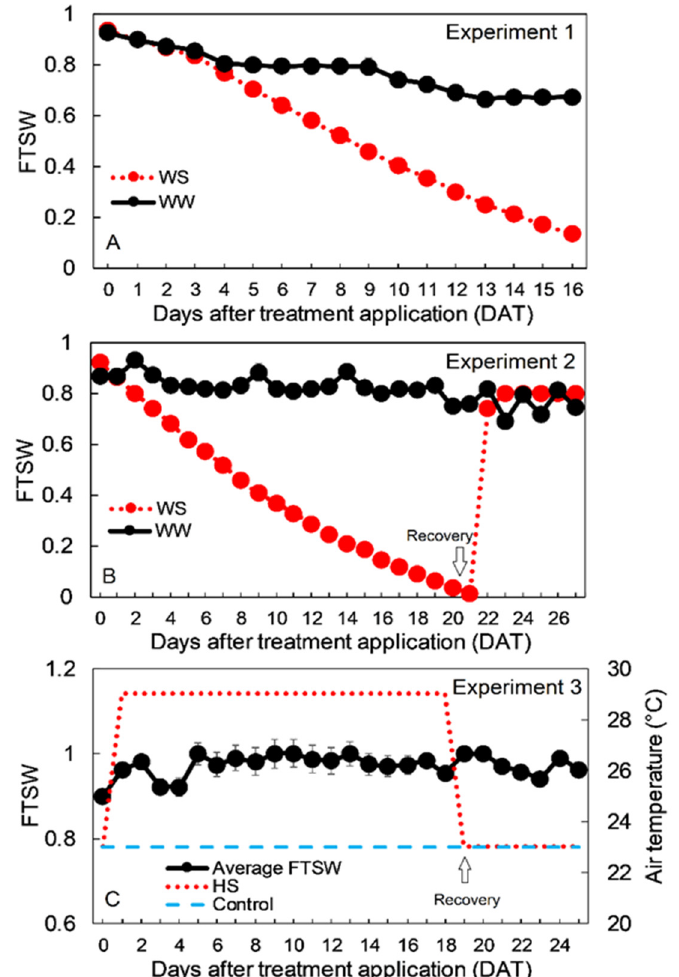
Figure 1. Environmental conditions for Experiment 1, 2, and 3 ( A – C , respectively). In A , black dots represent fraction of transpirable soil water (FTSW) of well-watered (WW) plants while red dots represent FTSW for water stress (WS) plants over a 16-day experimental period ( n = 50). In B , black dots represent FTSW of WW plants while red dots represent FTSW for WS plants over a 27-day experimental period ( n = 60). From days after treatment application (DAT) 22, WS plants were subjected to a recovery period. In C , black dots represent the average FTSW evaluated on three average pots per treatment ( n = 30), the red dotted line represents the average day-time air temperature of the heat stress (HS) chamber and the blue line represents the average day-time temperature of the control temperature (CT) chamber.